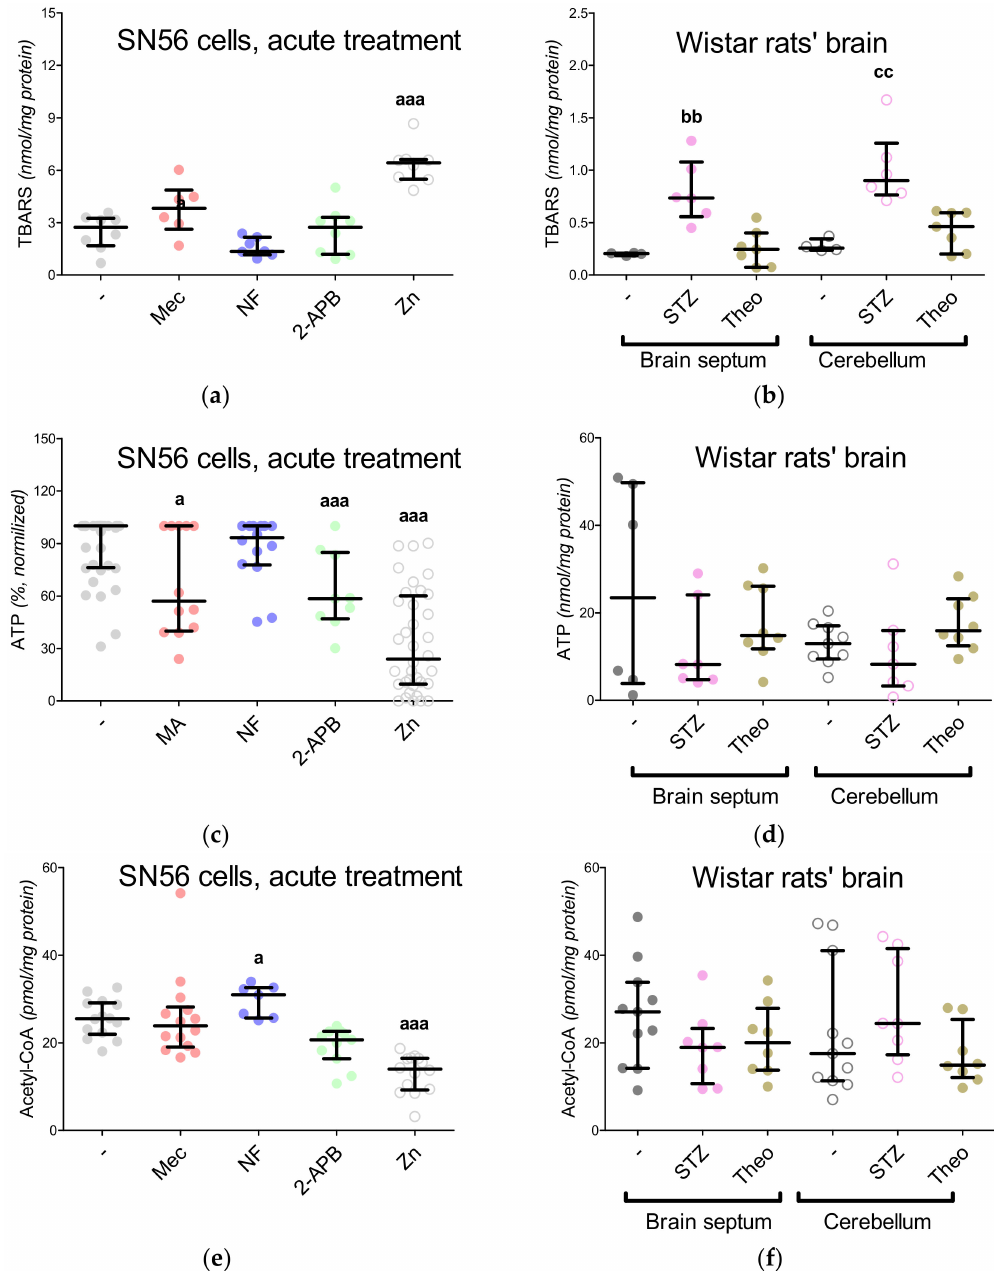
Figure 6. Metabolic profiles of SN56 cells ( a , c , e ) and Wistar rats’ brain tissues ( b , d , f ); ( a , b ) TBARS level; ( c , d ) ATP level (data normalized according to the highest value in each set of experiment, average control ATP level: 6.66 nmol / mg protein); ( e , f ) acetyl-CoA level. Data are median (25th–75th percentile) from 4–14 observations. Significantly di ff erent from SN56 control ( a — p < 0.05, aaa — p < 0.001) or Sham control brain septum ( bb — p < 0.01) or Sham control cerebellum ( cc — p < 0.01). Abbreviations: 2-APB—0.050-mM 2-aminoethoxydiphenyl borate; Mec—2 µ M mecamylamine; NF—0.01 mM nifedipine; STZ: streptozotocin; Theo: theophylline; Zn–zinc